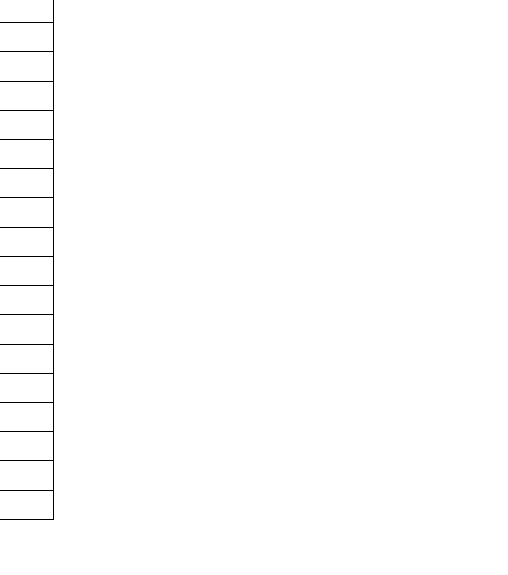
Table 1. Because the data come from TCGA, GEO, and ICGC, no additional permission from the ethics com- mittee is required, and all methods were performed in accordance with the relevant guidelines and regulations. Data preprocessing. To maintain data consistency, a subset of each expression profile according to the common gene was first taken, and then the data were merged. Subsequently, the batch effect was removed using the combat method of the SVA (version 3.42.0) R software package 11 . The combined dataset contained 1,468